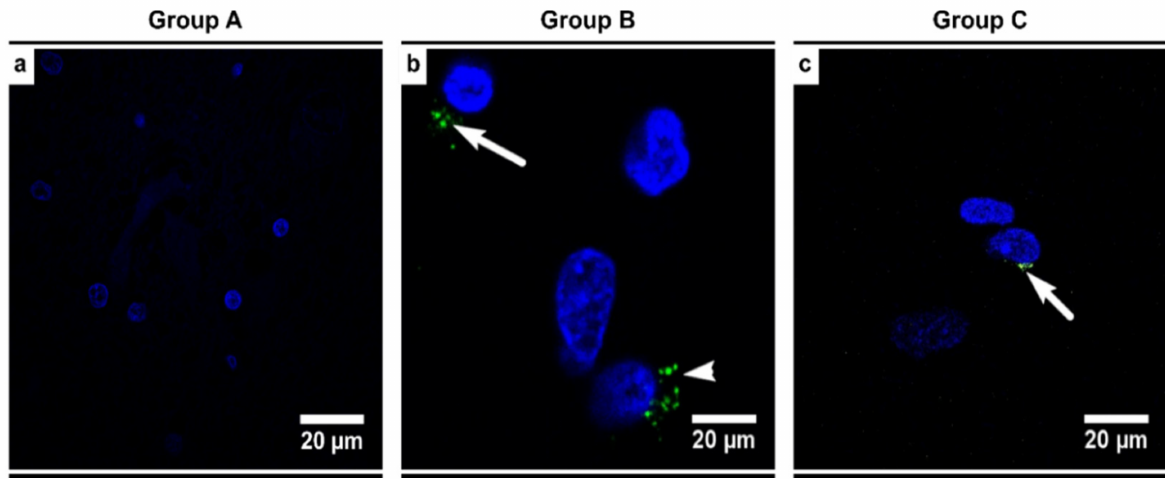
Figure 10. Representative images illustrating HHV-6 viral proteins (seen as green spots) using immunofluorescence (IF) in the gray matter of the alcoholics (confocal microscopy; original magnification × 1000). White arrows indicate the clusters of HHV-6 antigens—( a ) controls (Group A) showed no positivity whilst ( b ) age-matched alcoholics (Group B) and ( c ) chronic alcoholics (Group C) showed HHV-6 immunopositivity in the cell